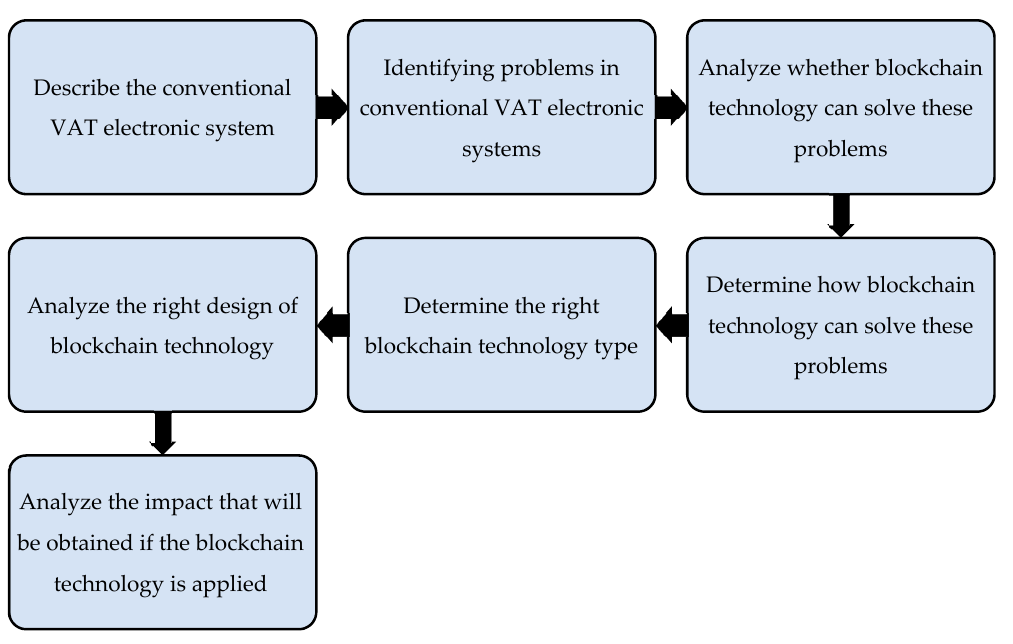
Figure 2. Buyer and seller position scheme in the Indonesian VAT system.